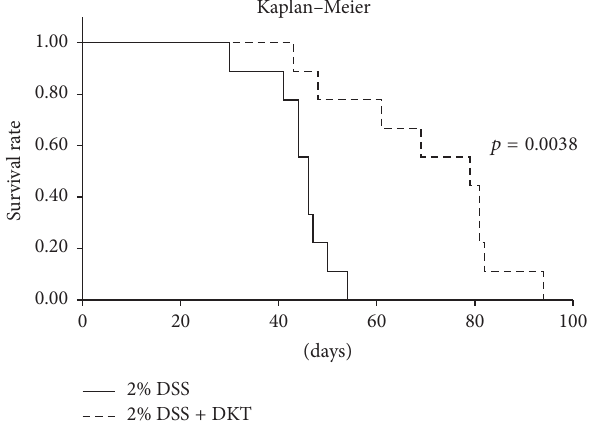
Figure 7: Survival time of each study group. 2% dextran sulfate sodium (DSS) group, mice provided with 2% DSS. 2% DSS + daikenchuto (DKT) group, mice provided with DKT in addition to DSS. 𝑛 = 9 mice (for 2% DSS and 2% DSS + DKT